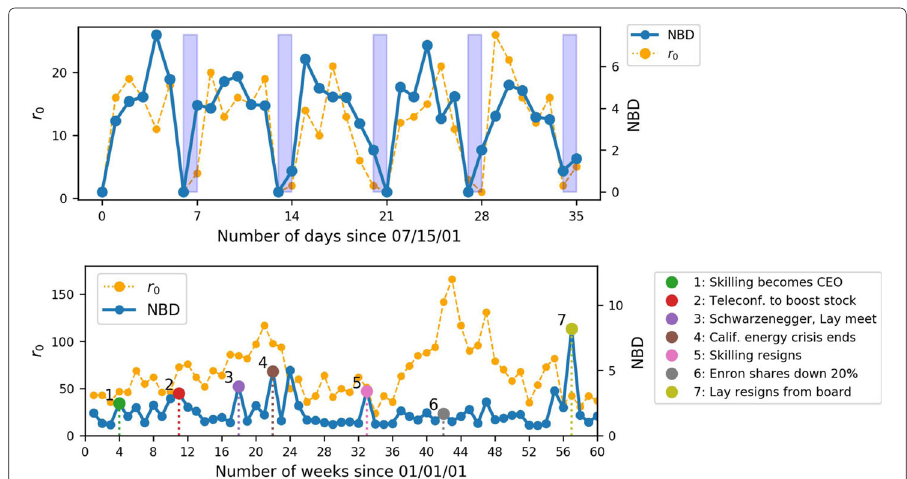
Fig. 13 NBD of daily and weekly Enron graphs. Top: data aggregated into daily graphs and compared to one arbitrarily chosen milestone (Sunday, July 15th, 2001). Weekends are shaded blue. The periodicity of weekly communications is recovered. Bottom: Data aggregated into weekly graphs and compared to the week starting on Monday January 1st, 2001. Most peaks in values of NBD corresponding to events occurring during the Enron scandal